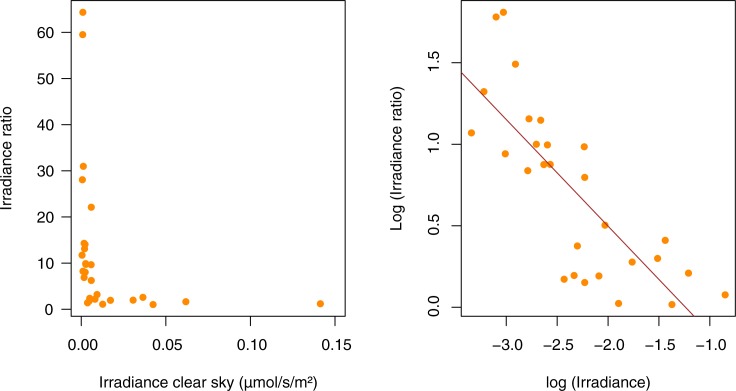
Variation of nocturnal light intensity as a function of cloud cover and baseline level of artificial lighting.The effect of cloud cover is estimated as the ratio of nocturnal irradiances (clear overcast sky over clear sky) against the baseline irradiance of a nocturnal clear sky during the new moon. (left) untransformed data, (right) log-log transformation. The line represents the model of linear regression (r2 = 0.612).